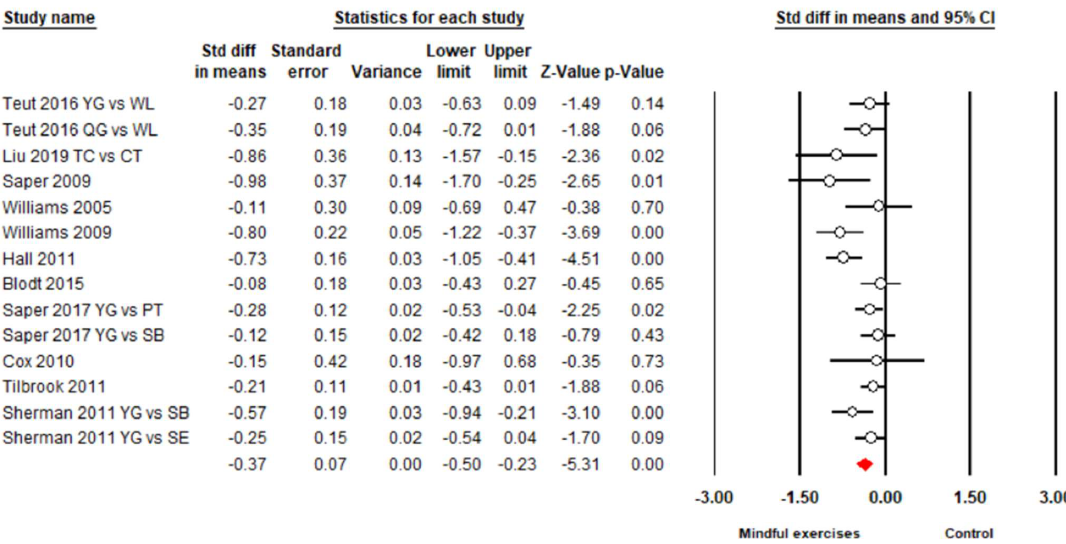
Figure 2. Funnel plot of publication bias for pain intensity.